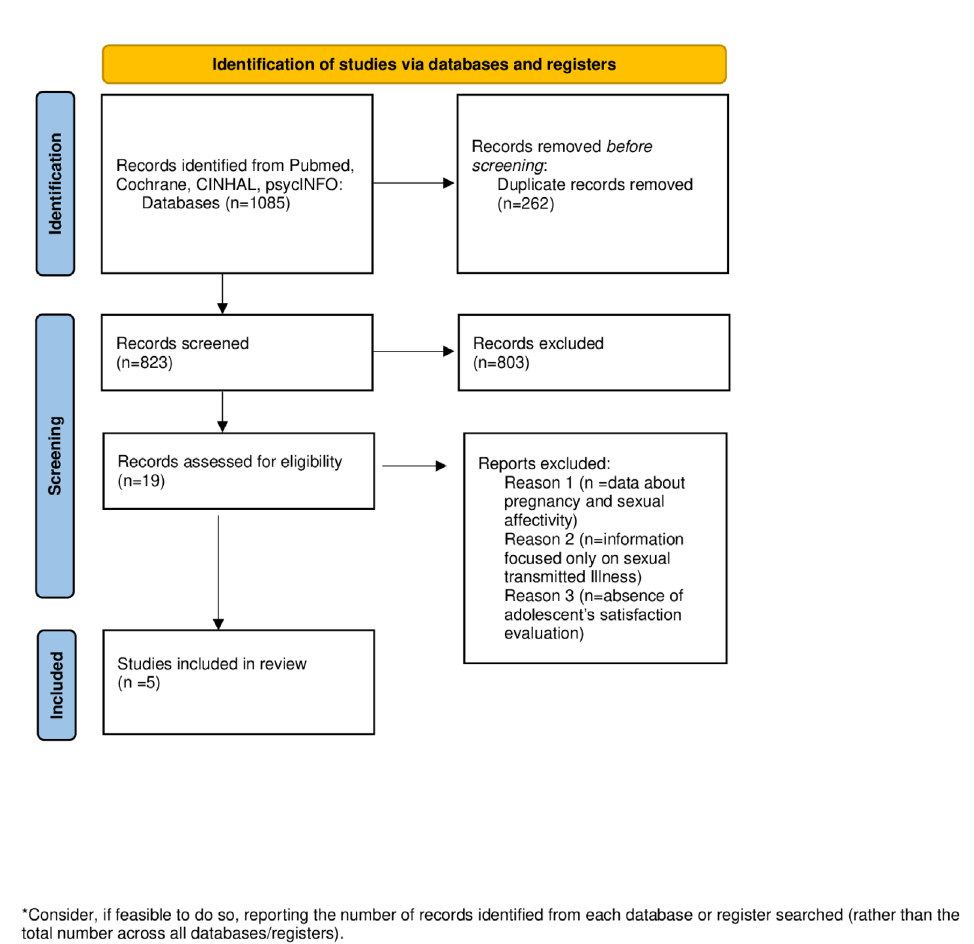
Figure 1. PRISMA Flow Diagram.